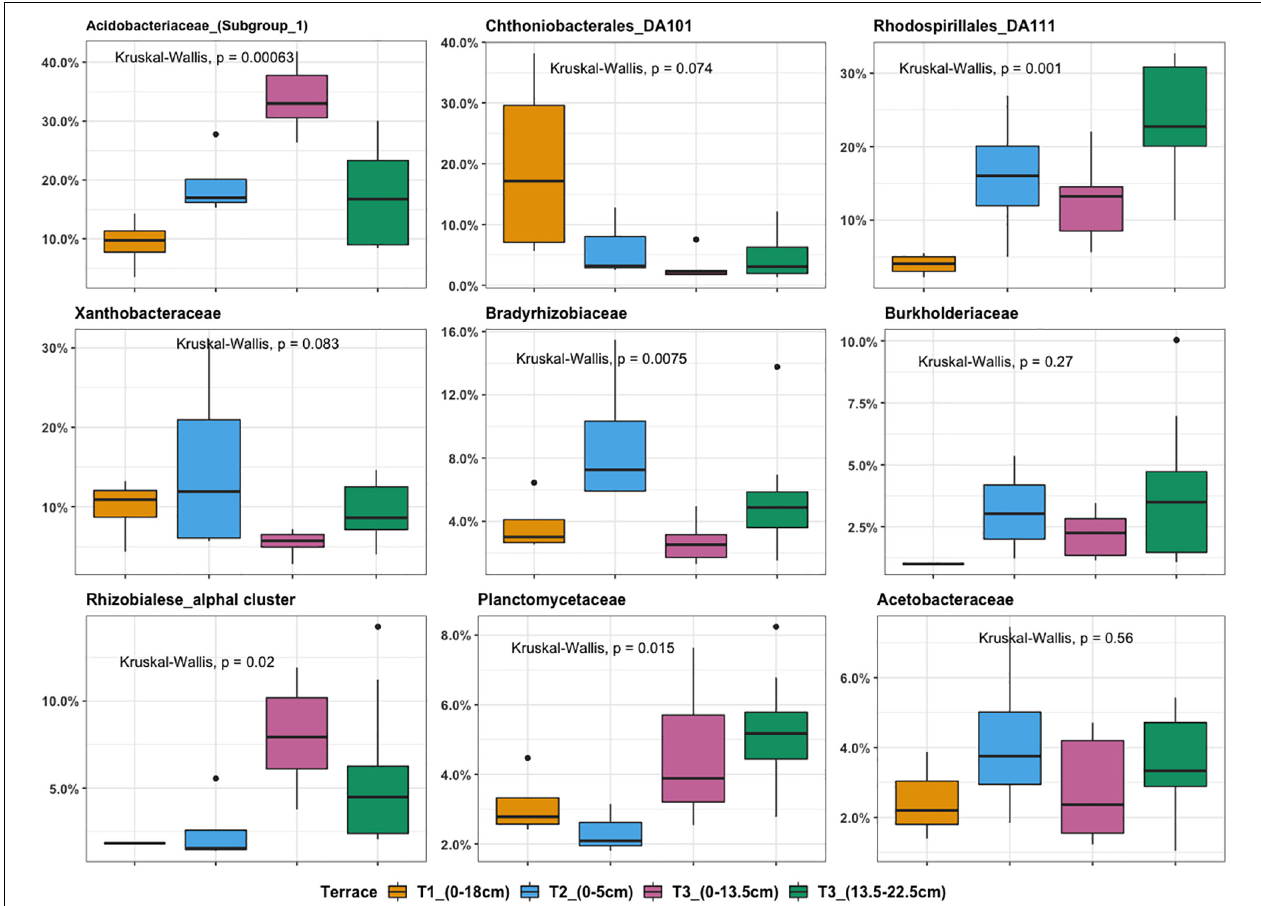
FIGURE 4 | Boxplot illustrating the most abundant bacterial families ranked by relative OTU distribution across terraces. The top and bottom of each box represent the 25th and 75th percentiles, the horizontal line inside each box represents the median and the whiskers represent the range of the points excluding outliers. Outliers are denoted as large points outside whiskers. Significant contributions of terrace locations and depths to observed differences in OTU relative abundance were tested using Kruskal-Wallis